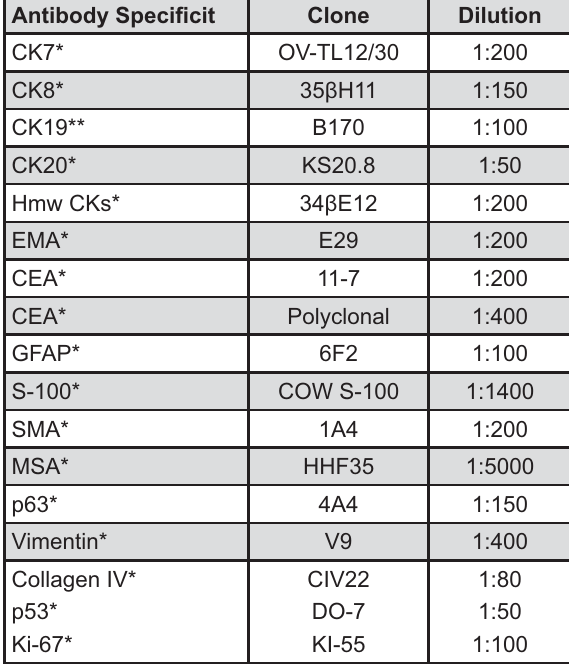
Figure 3- List of antibodies used for immunohistochemical